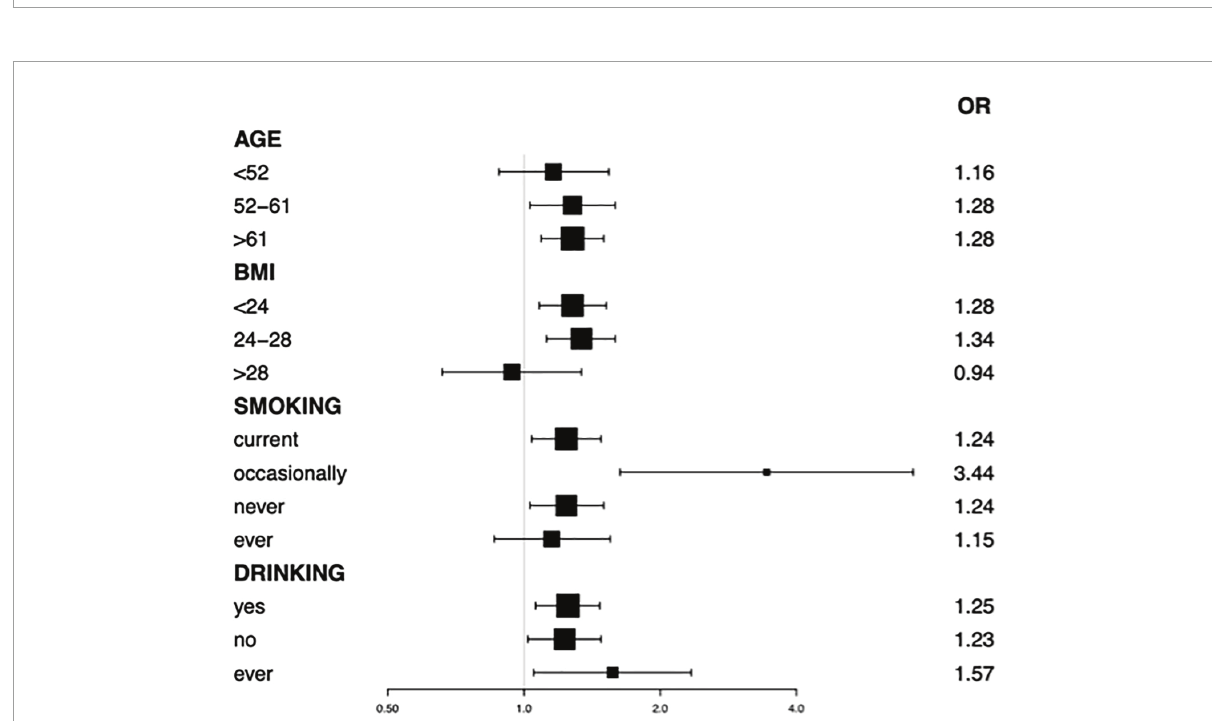
FIGURE4 Subgroup analysis by age, BMI, smoking, drinking status on association between PSQI with